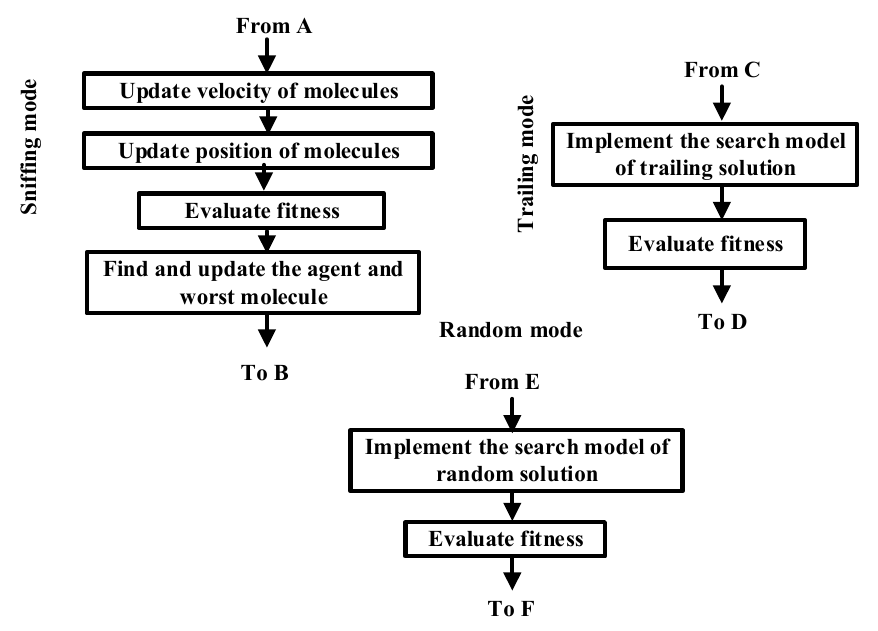
Figure 7. Di ff erent stages in SAO algorithm [28] .